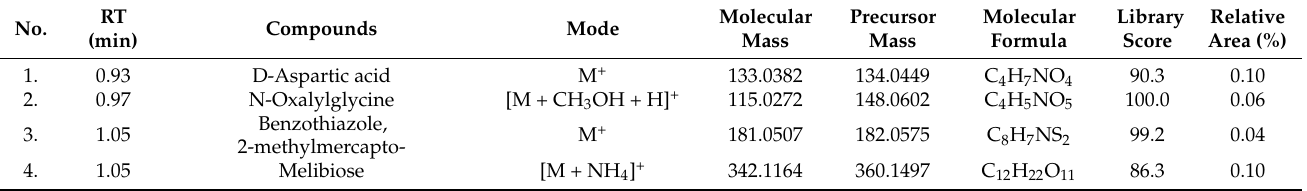
Table 1. Identification of chemical components of lime ( Citrus aurantifolia ) peel ethanolic extract using